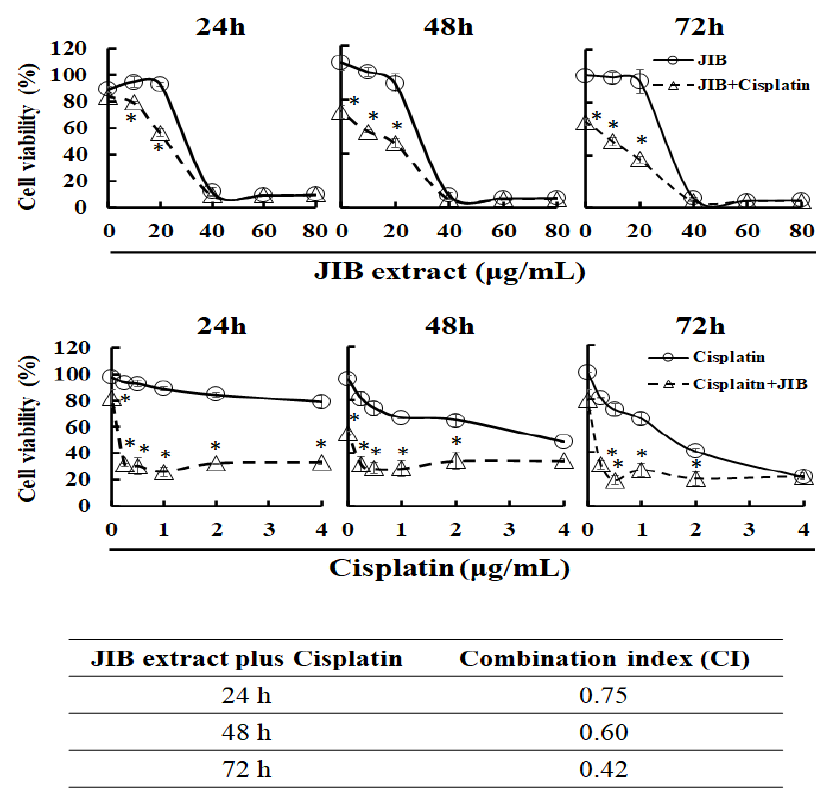
Figure 2. E ff ect of the combination of JIB extract and cisplatin on OECM-1 cells. OECM-1 cells (5 × 10 3 ) were seeded in 96 well plates and simultaneously treated with JIB extract and cisplatin for 24, 48 and 72 h. Cell viability is shown as the mean ± SD, and the experiment was performed in triplicate. ( p < 0.05).